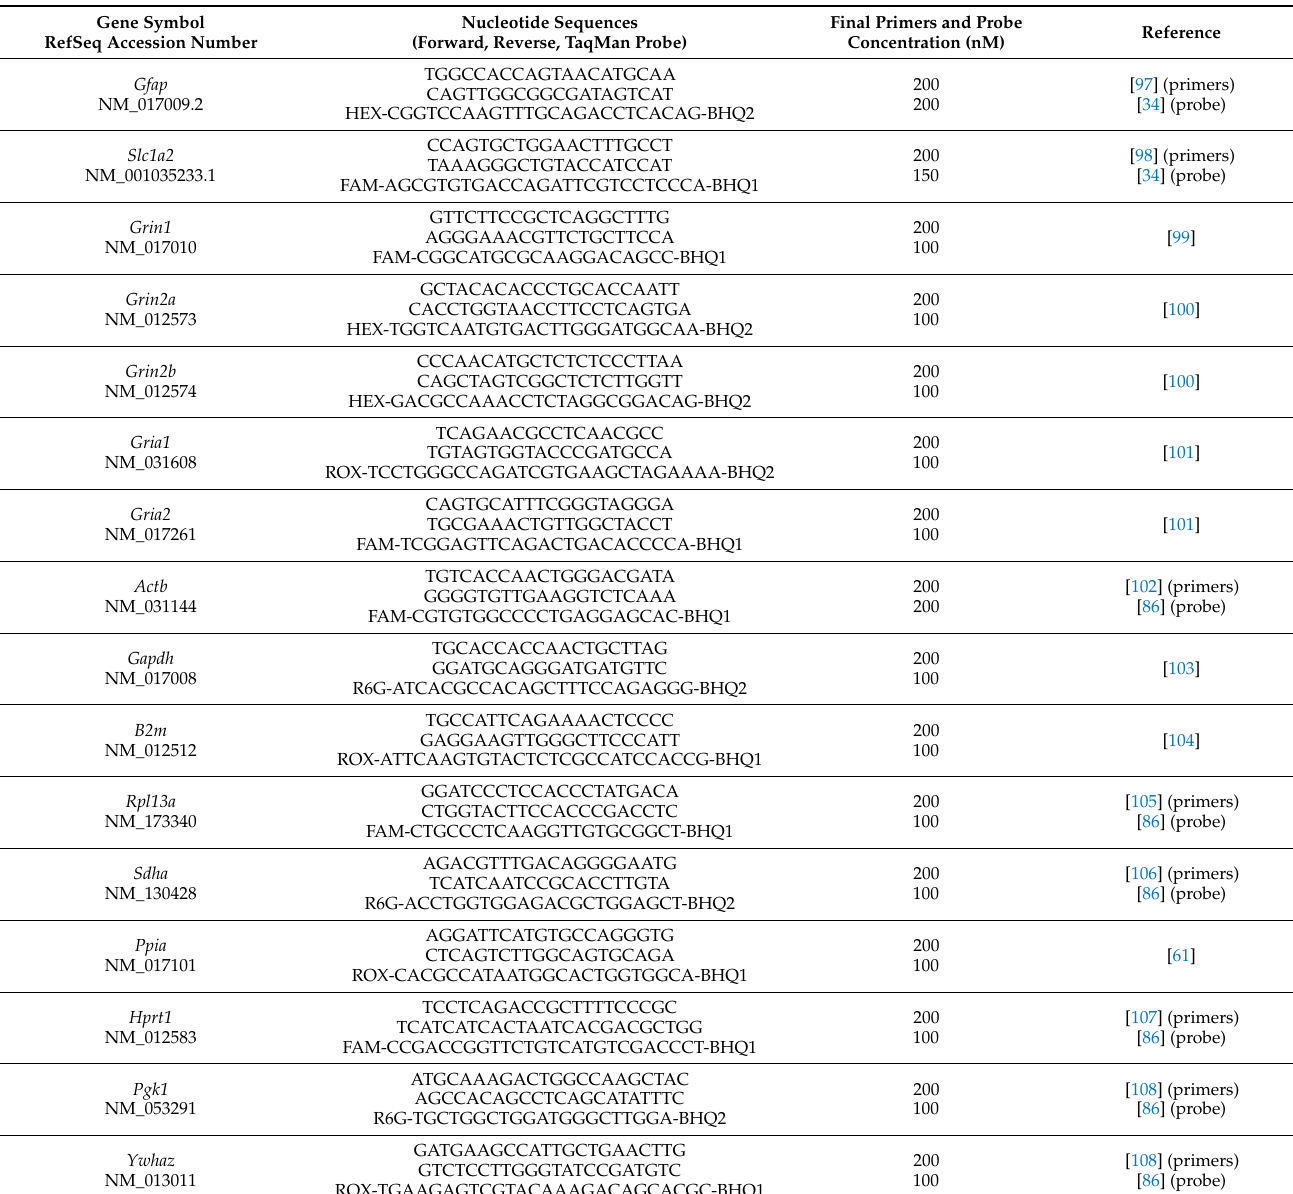
Table A1. Primers and probes used in